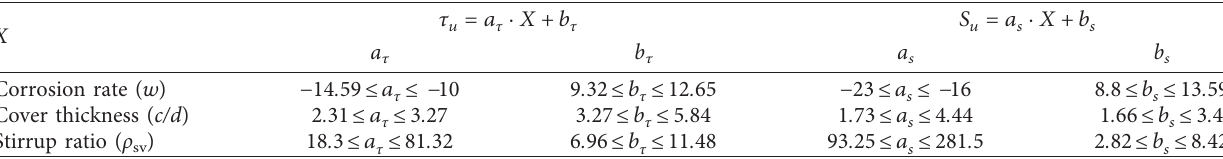
Table 6: The unified empirical formula.